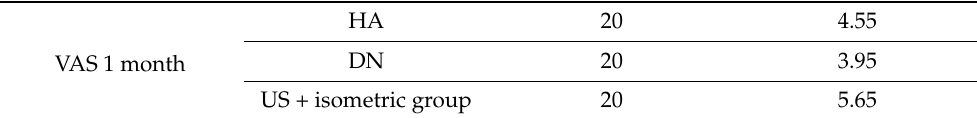
Table 5. VAS 1 month. Difference between US + isometric group with HA group. Difference between US + isometric group and DN